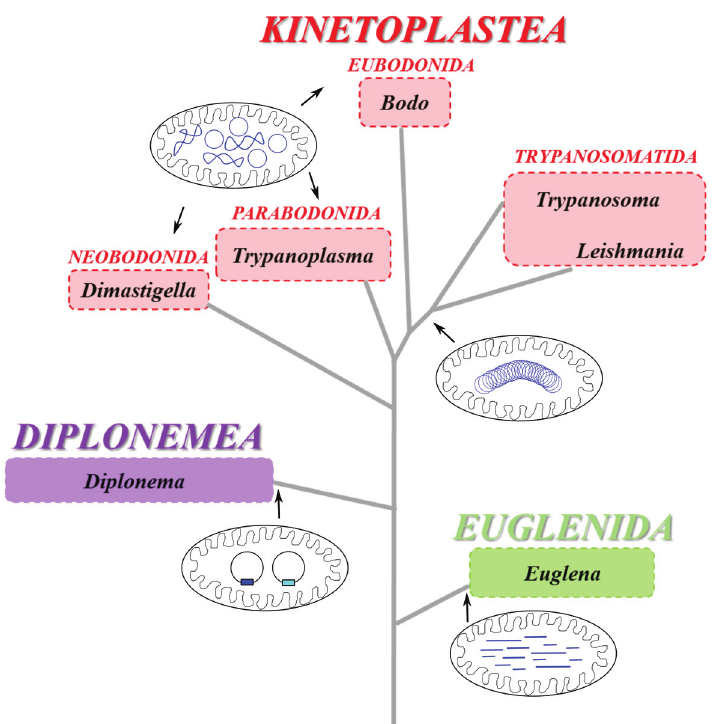
Figure 1. Schematic phylogenetic tree of representative genera of Euglenozoa depicting the organization of their mitochondrial genomes. The scheme is based on Adl et al. 1 (2012). Different organization of their mitochondrial genomes (in blue) is shown for the three major lineages: Kinetoplastea (in red), Diplonemea (in purple), and Euglenida (in green). Whereas Euglenida possess an array of linear mitochondrial DNA molecules of variable length, Diplonemea and Kinetoplastida contain in their organelle circular DNA